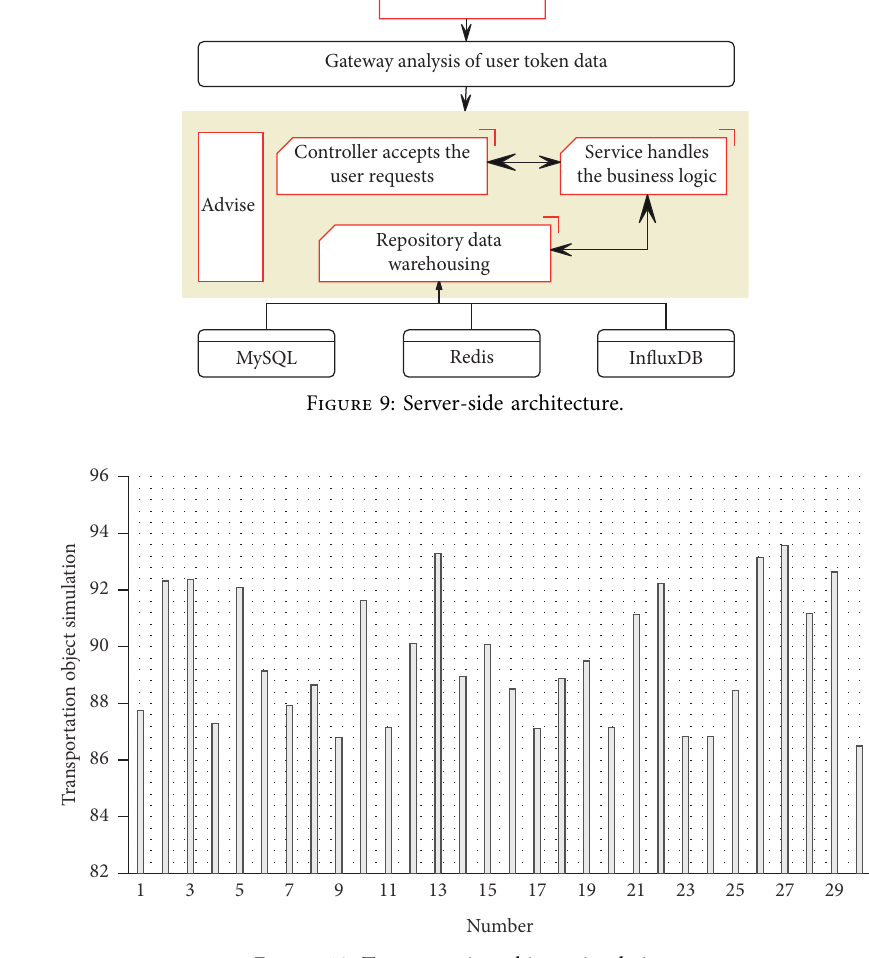
Figure 10: Transportation objects